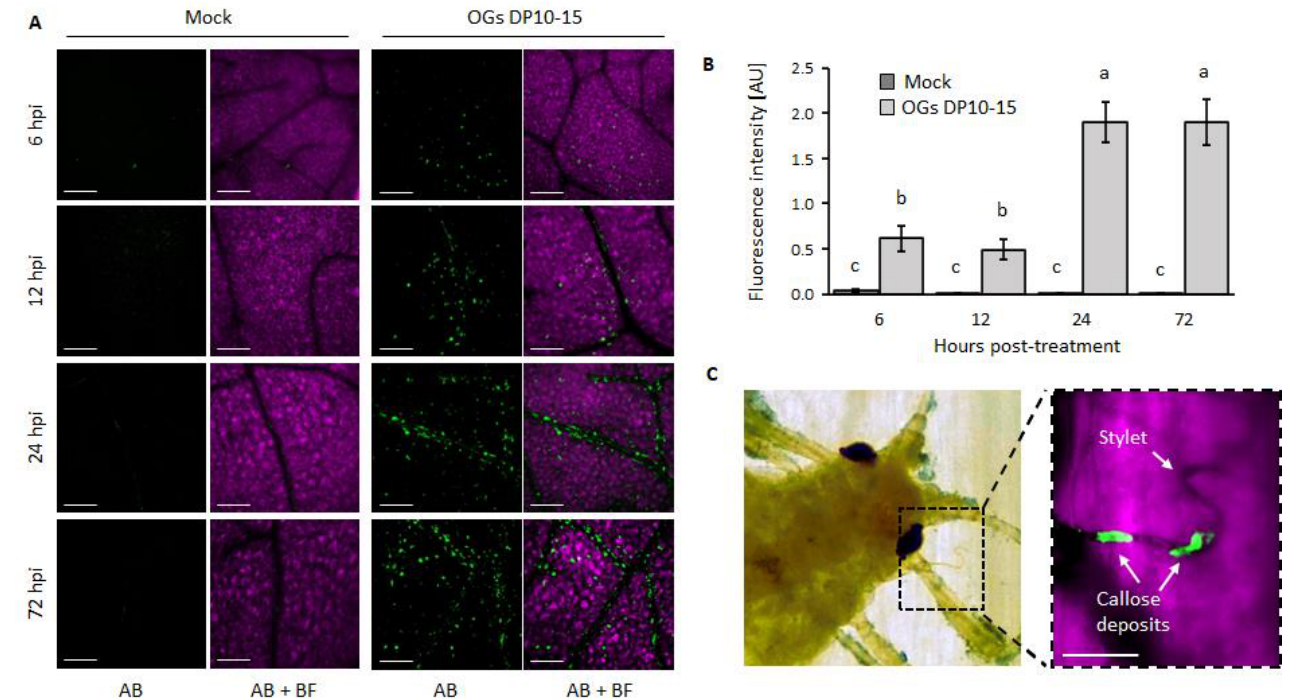
Figure 3. OGs induce the deposition of callose. ( A ) Representative images of callose deposits in mock- and OG-treated Arabidopsis plants. Fully expanded leaves of 4-week-old Arabidopsis plants were infiltrated with OGs (DP 10 – 15; 200 µg mL −1 ) or ultrapure water (mock) ( n = 8); scalebar = 200 µm. More replicates are shown in Supplementary Figures S3 – S6. ( B ) Plots show the fluorescence intensities measured from the figures in panel A using the ImageJ software. The fluorescent signal corresponds to callose deposits detected via aniline blue (AB) staining. The error bars correspond to standard error. Means followed by the same letter were not significantly different at p ≤ 0.05 by Fisher’s least significant difference test. ( C ) Callose deposits consistently formed at penetration sites surrounding the stylets of M. persicae after 6 h of feeding on an Arabidopsis leaf; scalebar = 50 µm. AB = aniline blue signal, BF = brightfield. More replicates are shown in Supplementary Figure S1.